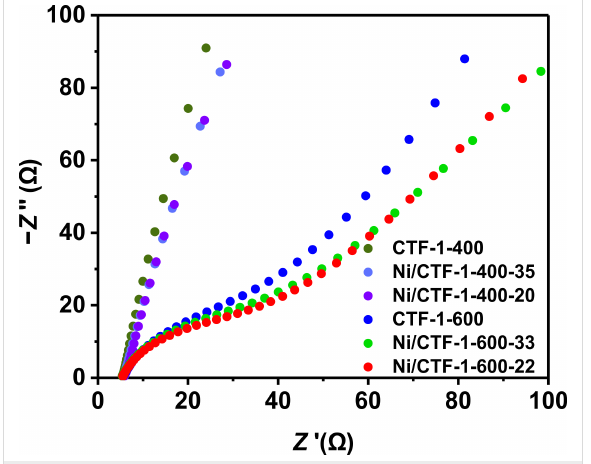
Figure 7: Nyquist plots recorded in 1 mol/L KOH solution.